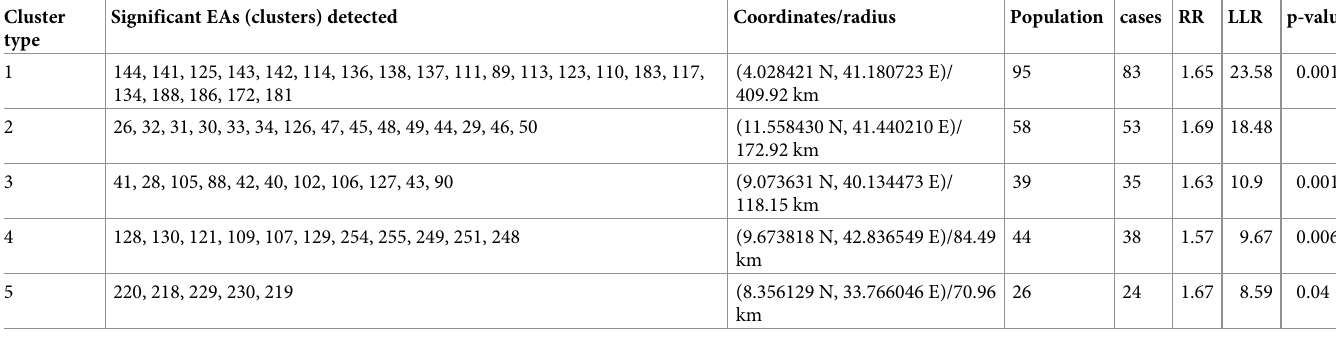
Table 3. SaTScan analysis of complete basic childhood vaccination among children aged 12–23 months in Ethiopia.